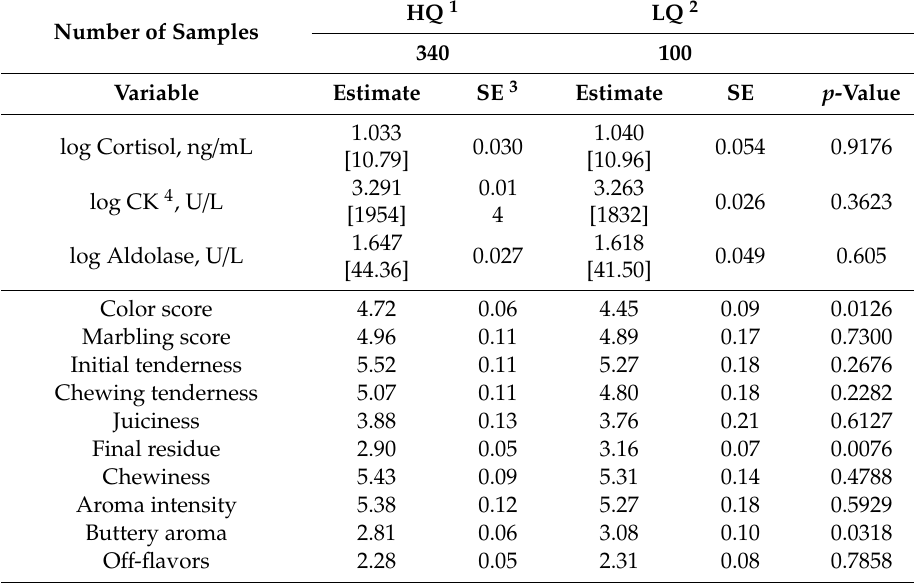
Table 3. Results of the linear mixed-model procedure to identify statistical di ff erences between the two clusters in the measured blood parameters and sensory attributes of meat. Back-transformed data are presented between square